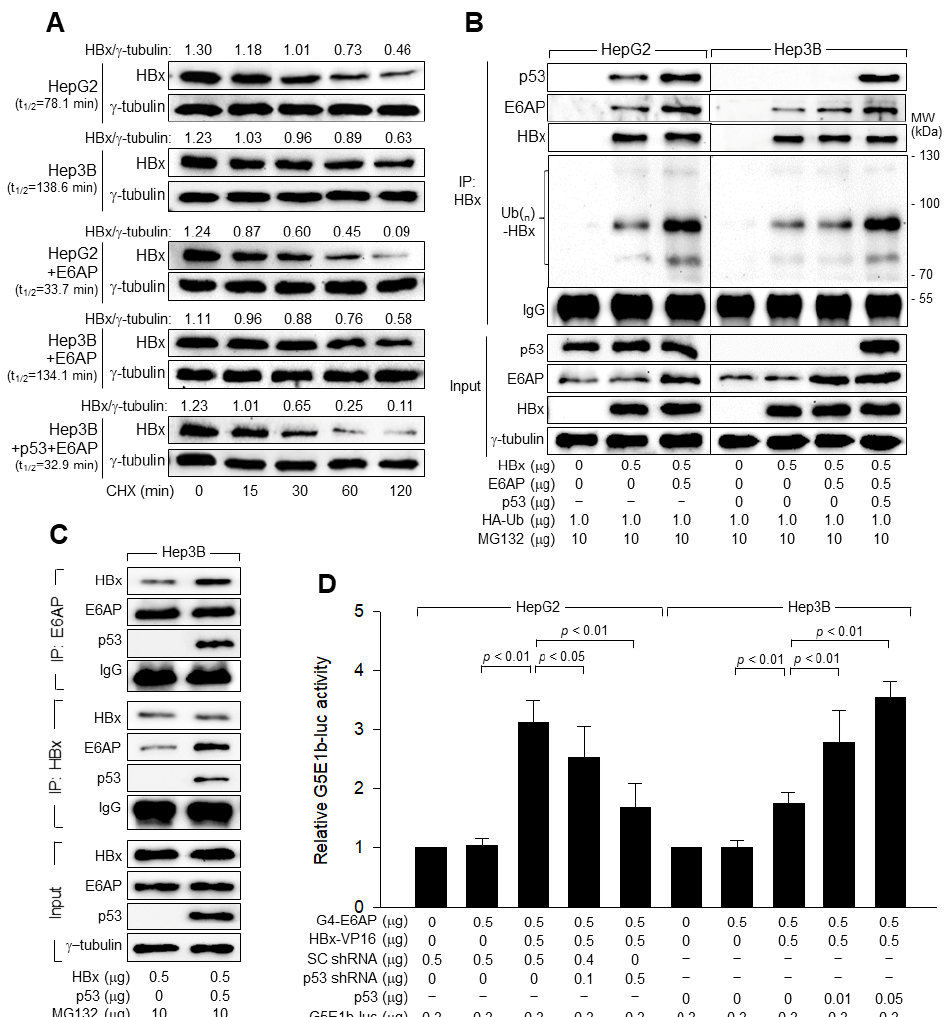
Figure 8. p53 induces E6AP-mediated ubiquitination and proteasomal degradation of HBx. ( A ) HepG2 and Hep3B cells were transfected with HBx, E6AP, and p53 expression plasmids for 48 h as described in ( B ) and treated with 50 μ M CHX for the indicated time before harvesting. The levels of HBx and γ -tubulin were quantified, as described in Figure 5A, to determine the t 1/2 value of HBx. ( B ) HepG2 and Hep3B cells were transfected with HBx expression plasmid along with the indicated plasmids for 48 h and then treated with 10 μ M MG132 for 4 h before harvesting. Total HBx protein in the cell lysates was immunoprecipitated with an anti-HBx antibody and subjected to Western blotting using anti-p53, anti-E6AP, anti-HBx, and anti-HA antibodies to detect p53, E6AP, HBx, and HA-Ub-complexed HBx, respectively. The input shows the levels of the indicated proteins in the cell lysates. ( C ) Hep3B cells were transfected with the HBx expression plasmid along with either an empty vector or p53 expression plasmid for 48 h and then treated with 10 μ M MG132 for 4 h before harvesting. E6AP and HBx in cell lysates were immunoprecipitated with anti-E6AP and HBx antibodies, respectively. Western blotting was performed to detect HBx, E6AP, and p53 in the immunoprecipitates and cell lysates. ( D ) For mammalian two-hybrid assays, HepG2 and Hep3B cells were transfected with G5E1b-luc, pSG424-E6AP (G4-E6AP), and pCMV HBx-VP16 (HBx-VP16), along with SC shRNA, p53 shRNA, or p53 expression plasmid for 48 h, followed by a luciferase assay. The values indicate the relative luciferase activity compared with the basal level of the control ( n = 5).